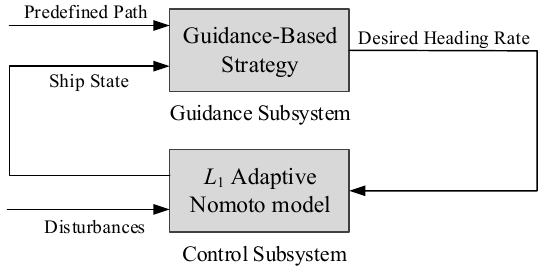
Figure 2. Path-following control strategy.